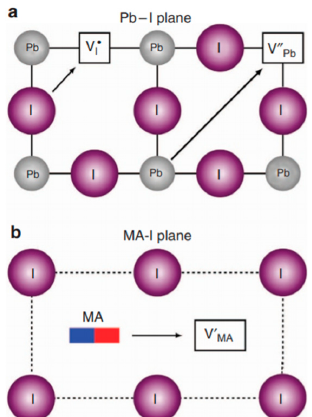
Figure 8. Ion transport mechanisms in MAPbI 3 . ( a ) I – migration along an octahedron edge; Pb 2+ migration along diagonal direction ( 110 ). ( b ) MA + migration into a neighboring vacant A-site. Reproduced with permission from Nat. Commun. 2015 , 6 , 7497 . Reference [4].